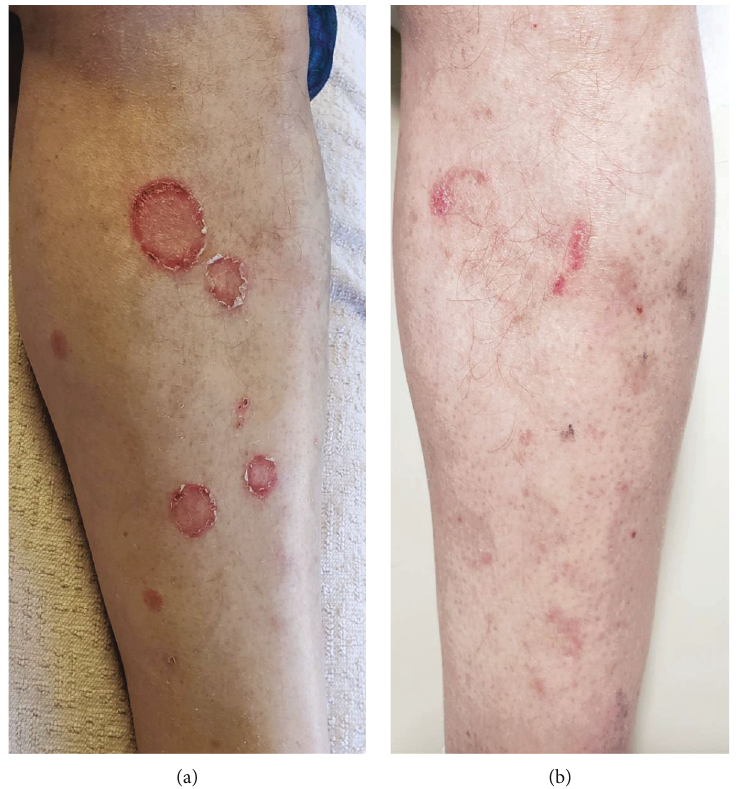
Figure 1: Solid organ transplant-associated cutaneous graft-versus-host disease (a) prior to antithymocyte globulin (ATG) and (b) 3 months after